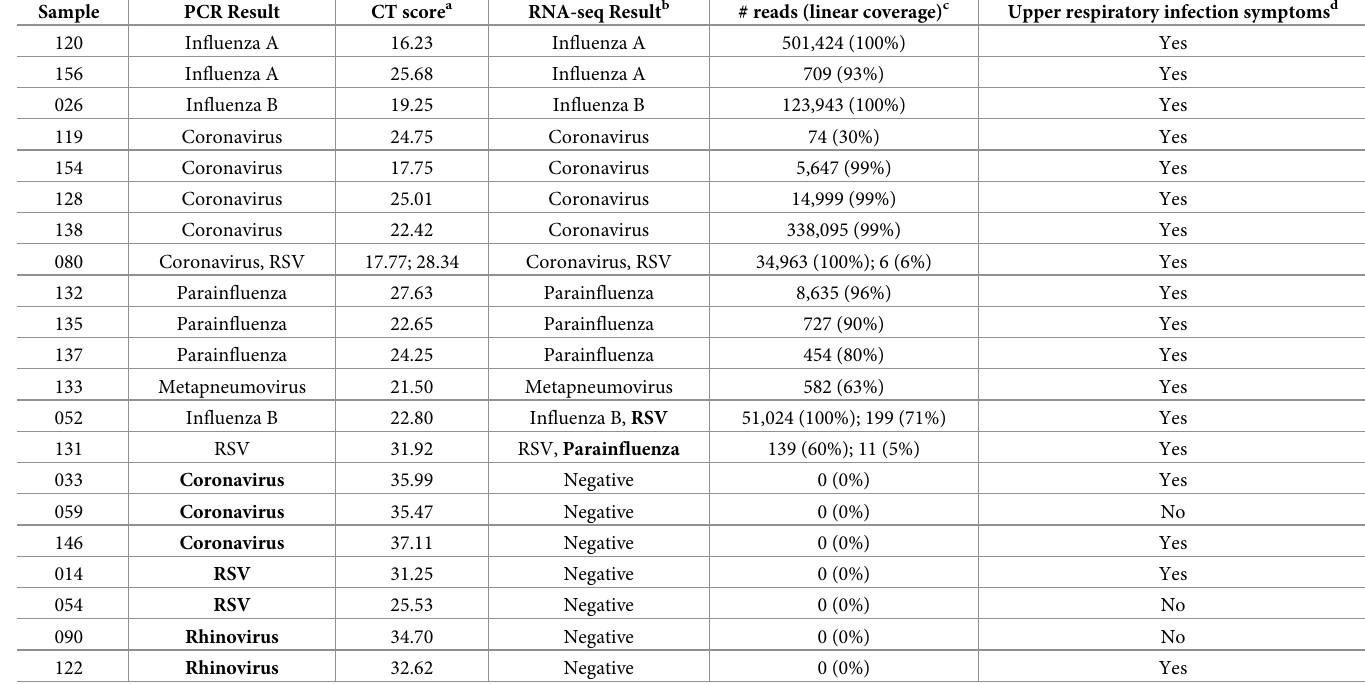
Table 2. Respiratory viruses detected by PCR and shotgun RNA sequencing. For the PCR panels, the Ct cutoff for a positive result was 40 and a value between 35 and 40 indicated a weak positive sample. Sample